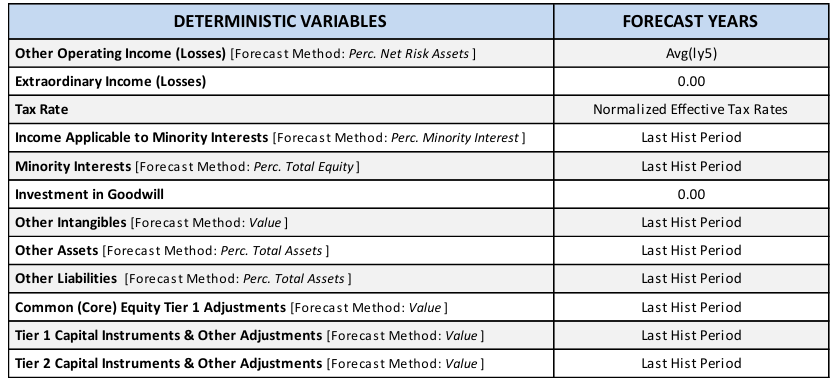
Figure A2. Deterministic variables: modeling & assumptions.